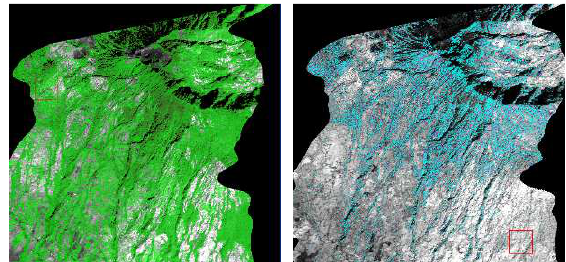
Figure 1. NDVI (left) abundante and TCARI/OSAVI (right) in Turrialba volcano from HyMAP image of March